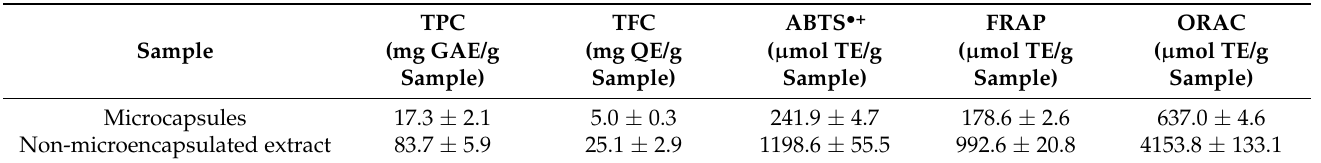
Table 3. Total phenolic compounds, flavonoids, and antioxidant capacity ABTS • + , FRAP, and ORAC from oregano ( Lippia graveolens ) extract and